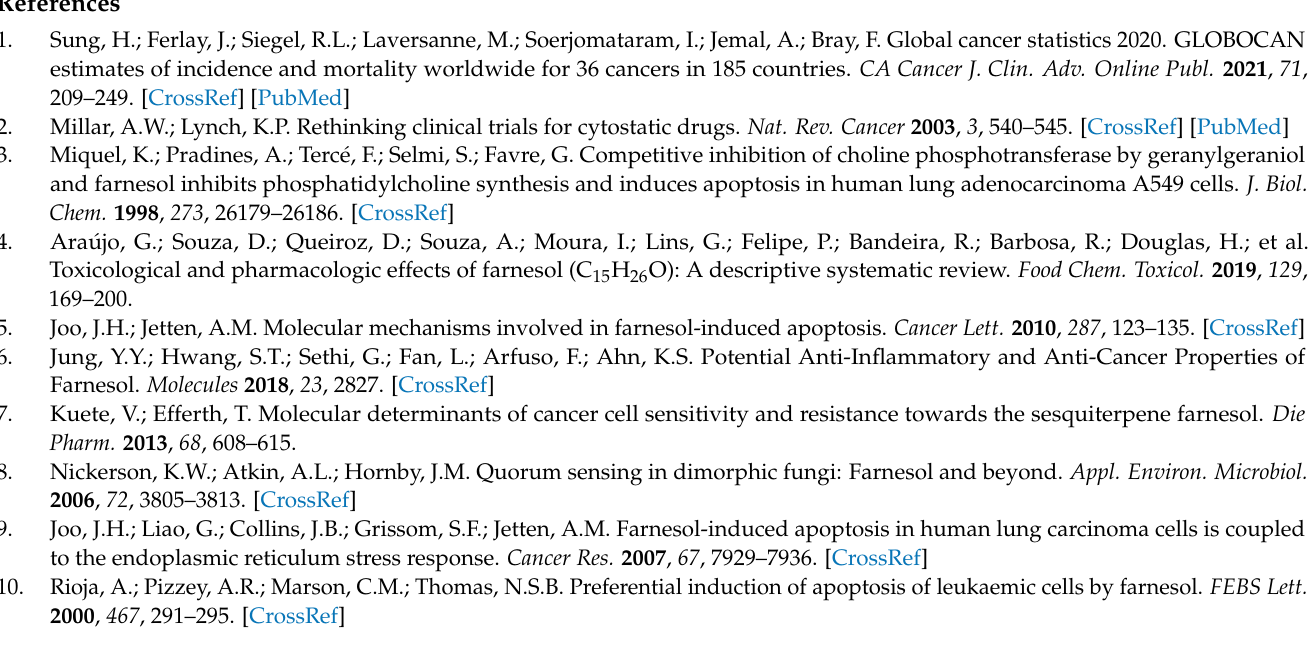
Figure S2: Cyclodextrin structure; Figure S3: Calculation of proportion ration FOH-CD; Figure S4: Series of NMR spectra (stability); Figure S5: Series of NMR spectra at different temperatures; Figure S6: UV-Vis spectrums of dilutions of different types of FOH; Figure S7: DLS and Z-potential; Figure S8: Curve fitting for IC50 estimation; Figure S9: Effect of external addition of PC; Figure S10: variation of cell viability (48 h) in presence of PC; Figure S11: ANOVA tables; Figure S12: cell phase